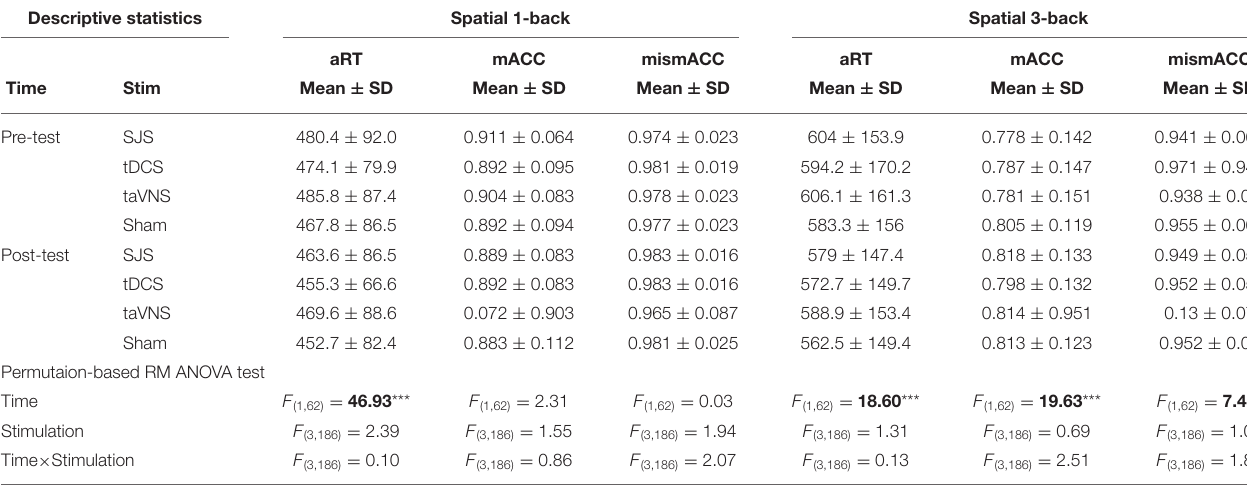
TABLE 3 | Means, standard deviations, and two-way ANOVA results of WM tasks in experiment 2. Descriptive